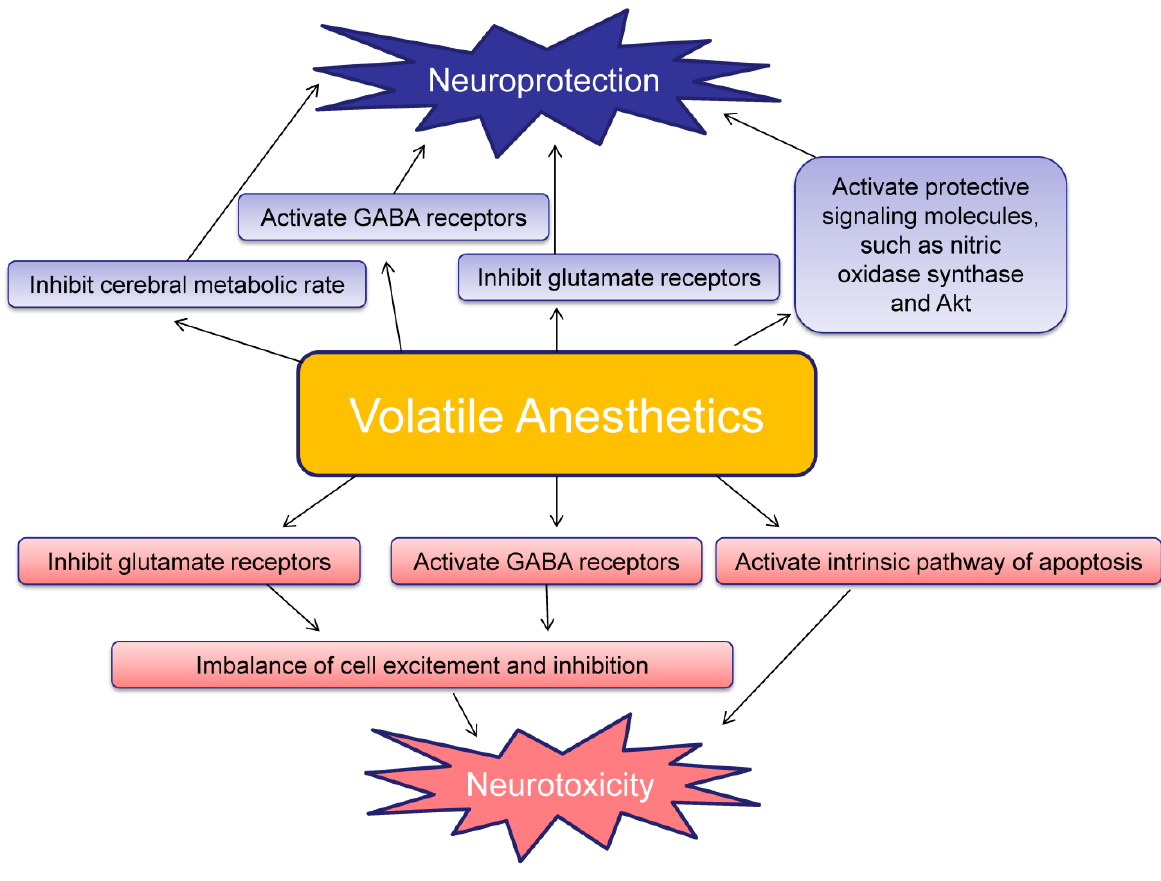
Figure 1. Schematic of the neuroprotective and neurotoxic effects induced by volatile